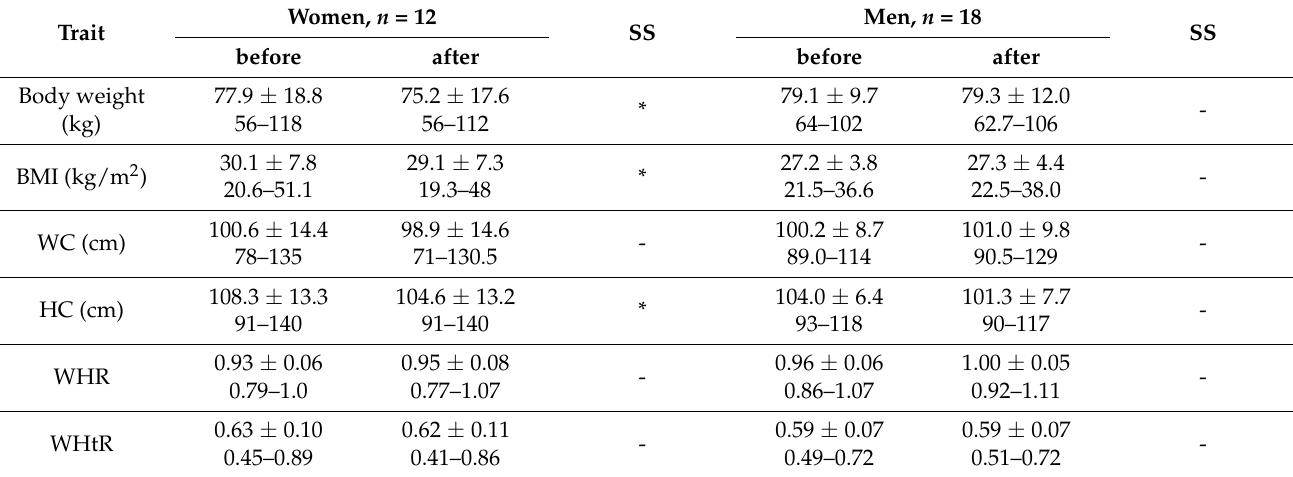
Table 5. Impact of diet correction on selected anthropometric parameters of nutritional status, DPS − patients suffering from schizophrenia; x ± SD, min–max.